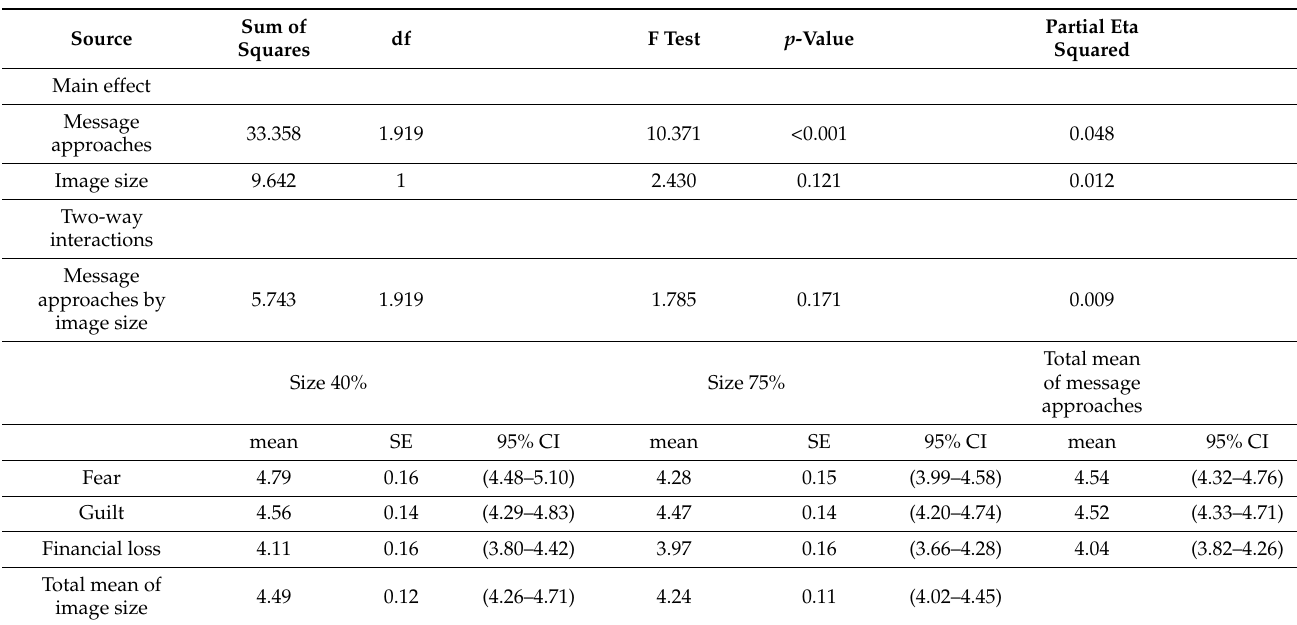
Table 2. Effectiveness of pictorial health warning by message approaches and image size.